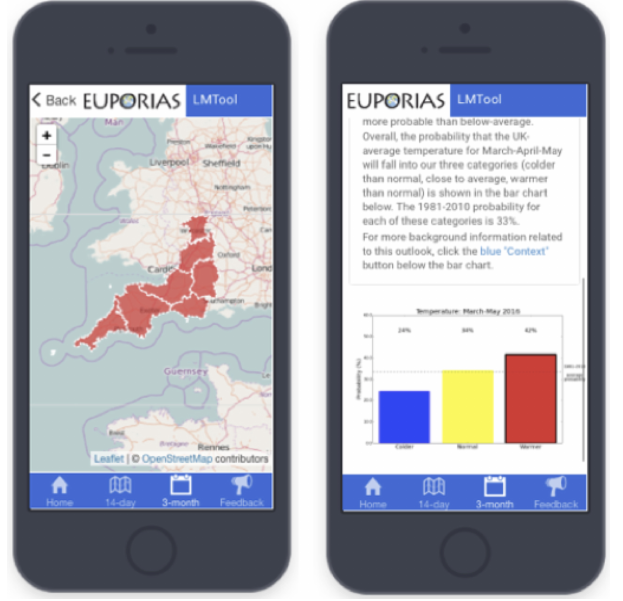
Figure 3. Seasonal climate forecast for temperature for March– May 2016 provided to the farmers through the